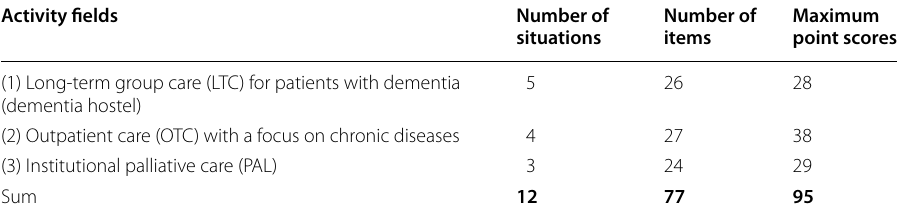
Table 2 Number of situations and items and maximum point scores according to activity fields/ major care